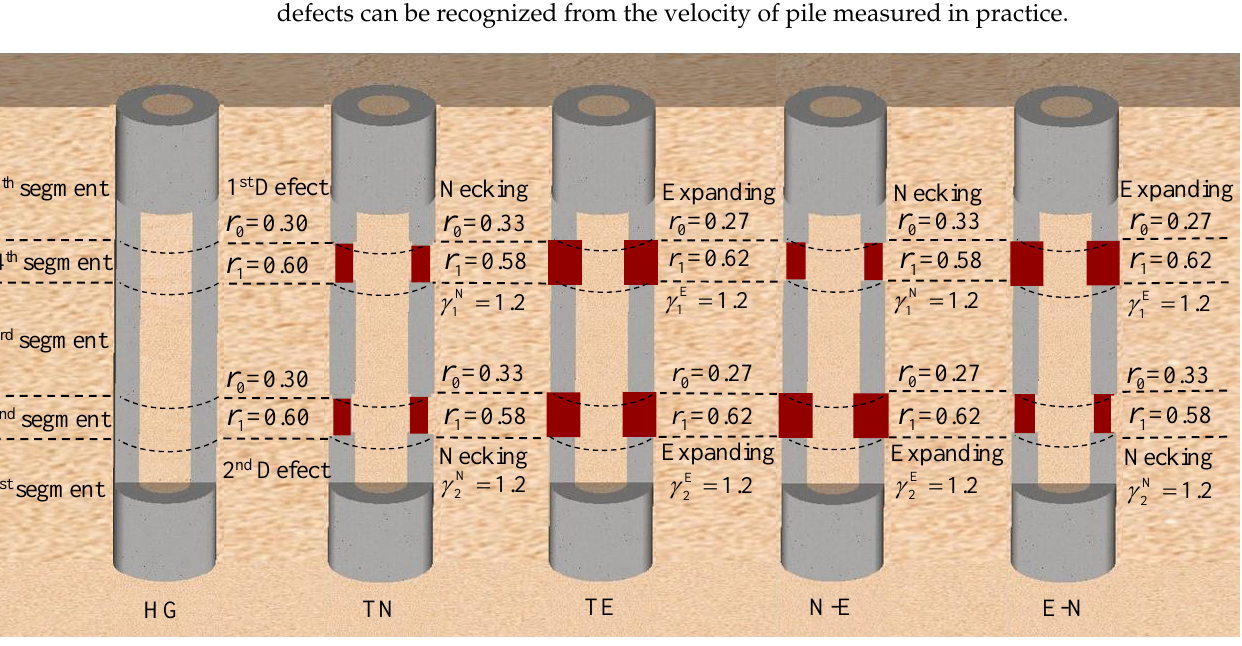
Figure 7. Diagram of defect distribution.